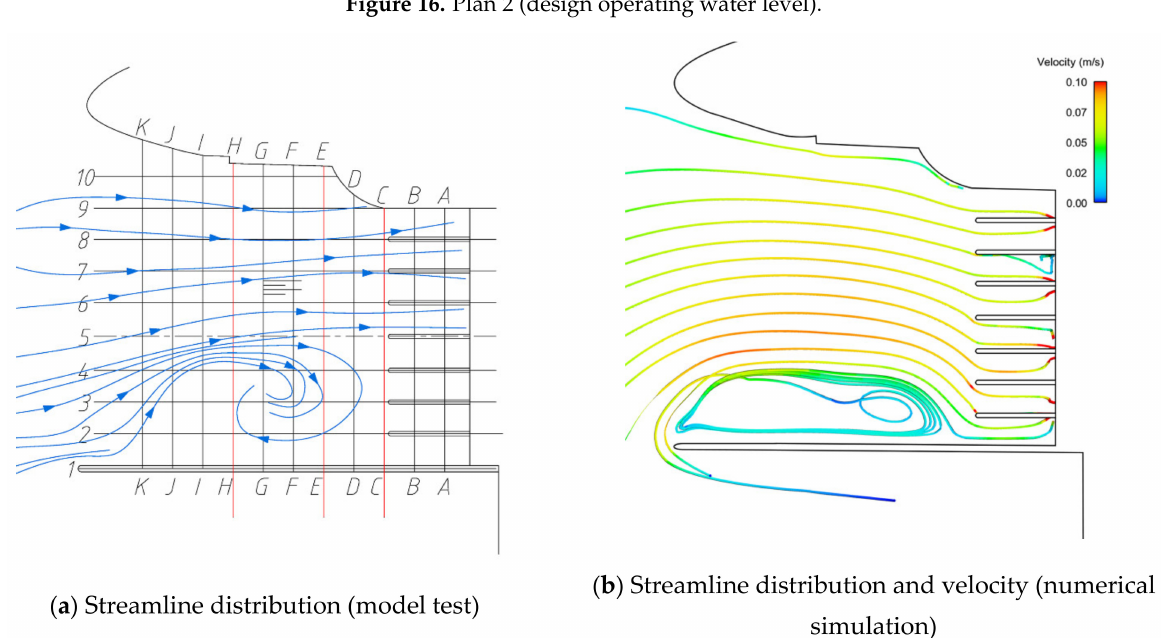
Figure 17. Plan 3 (design operating water